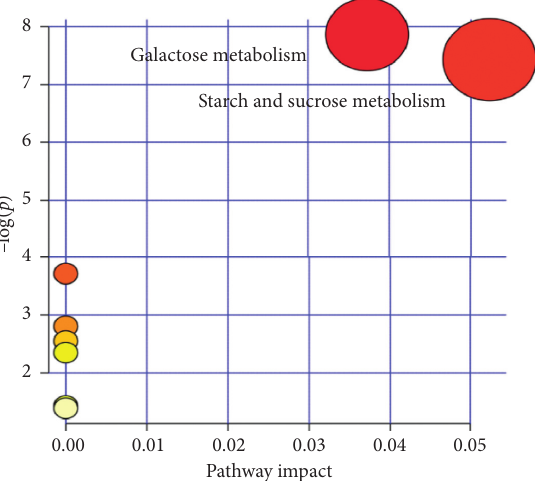
Figure 3: Metabolic pathway analysis of potential biomarkers by MetaboAnalyst